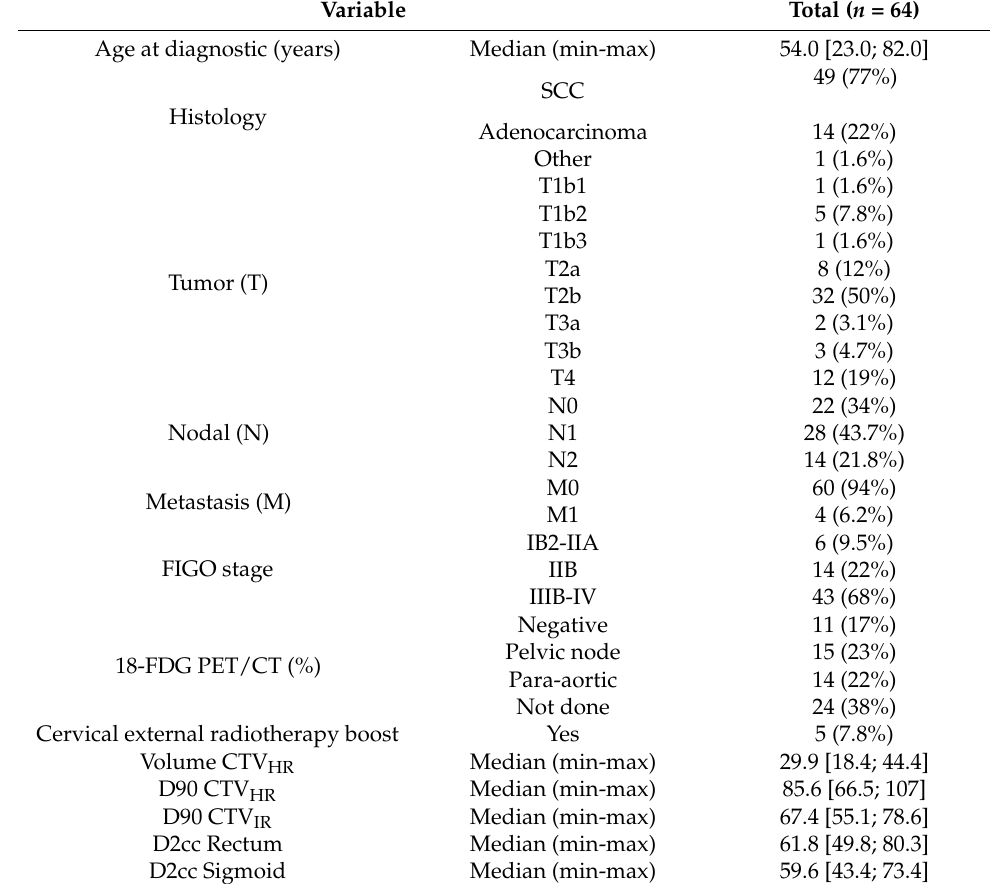
Table 1. Patient, disease, and treatment characteristics.